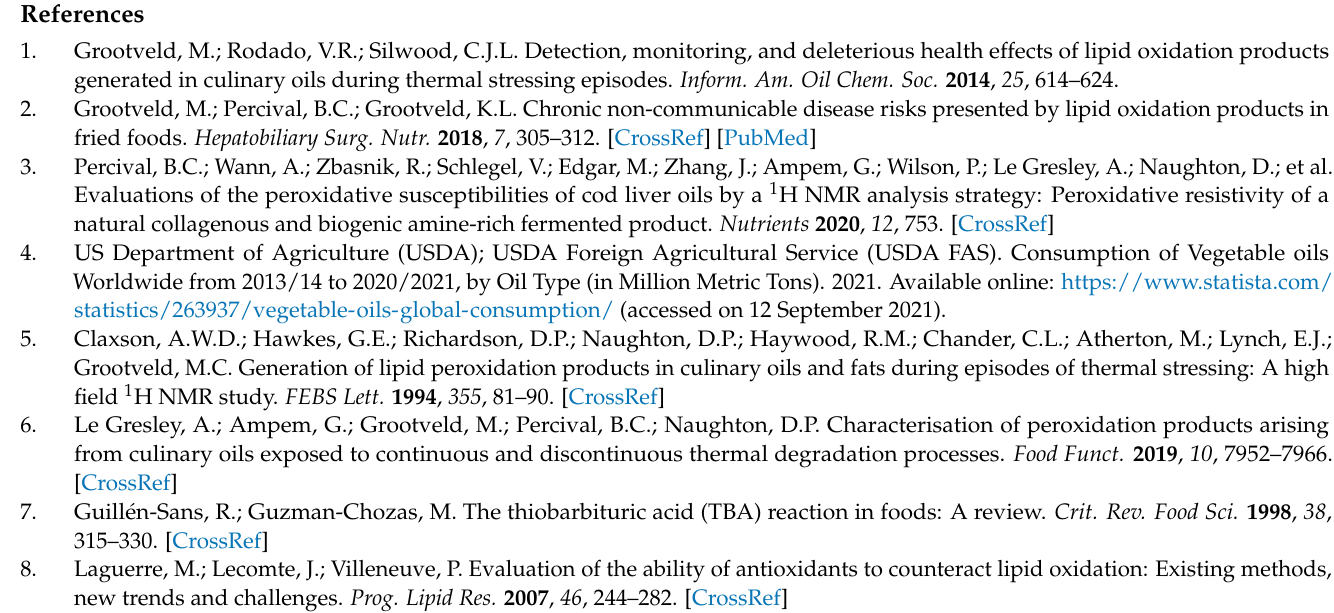
oils. Letter assignments of resonances correspond to those provided in Table 3. Figure S2: 1 H NMR spectra showing expanded 5.5–7.0 ppm regions of (i) walnut oil thermally stressed at different times and (ii) culinary oils thermally stressed at 300 min which reveal CHPDs, HPMs, and the olefinic resonances of α , β -UAs. Letter assignments of resonances correspond to those provided in Table S2. Figure S3: 1 H NMR spectra showing expanded 7.8–9.0 ppm regions of (i) macadamia oil and (ii) extra virgin olive oil thermally stressed for increasing times, which reveal broad resonances attributable to hydroperoxide groups (primary LOPs) and formic acid. Letter assignments of resonances correspond to those provided in Table S2. Figure S4: 1 H NMR spectra showing expanded 2.3–4.0 ppm regions of (i) walnut oil thermally stressed at increasing time-points and (ii) culinary oils thermally stressed at 300 min, at 180 ◦ C, which reveal resonances attributable to epoxy-FAs and primary alcohols, both types of LOP classified as secondary LOPs, although epoxy-FAs may also represent primary LOPs. Letter assignments of resonances correspond to those provided in Table S3. Figure S5: The chemi- cal structure of 1,3,5-tribromobenzene (TBB). Figure S6: Evolution of aldehydic LOPs in thermally stressed culinary oils subjected to a continuous thermo-oxidation at 180 ◦ C for 300 min. All values are presented as mean ± SD mM (mmol LOPs per 1.0 L oil). Figure S7: Evolution of aldehydic LOPs in thermally stressed culinary oils subjected to a discontinuous thermo-oxidation at 180 ◦ C for 480 min. All values are presented as mean ± SD mM (mmol LOPs per 1.0 L oil). Figure S8: Evolutions of aldehydic LOPs (minor types) in unheated and thermally-stressed culinary oils exposed to continuous and discontinuous thermo-oxidation episodes at 180 ◦ C for a 120 min period. References [36–43] are cited in the supplementary